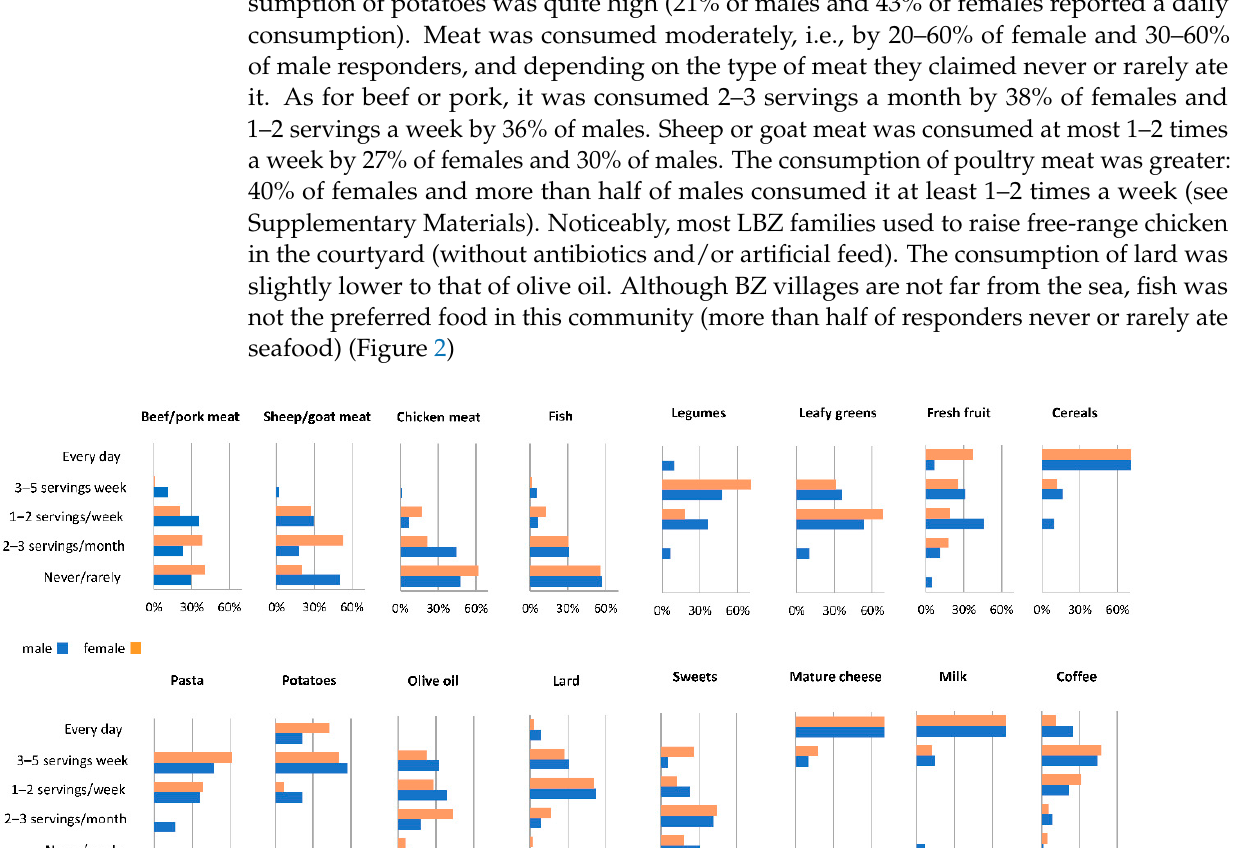
Figure 2. Percentage frequency of consumption of 16 food items among the study participants, reported in the x axis.